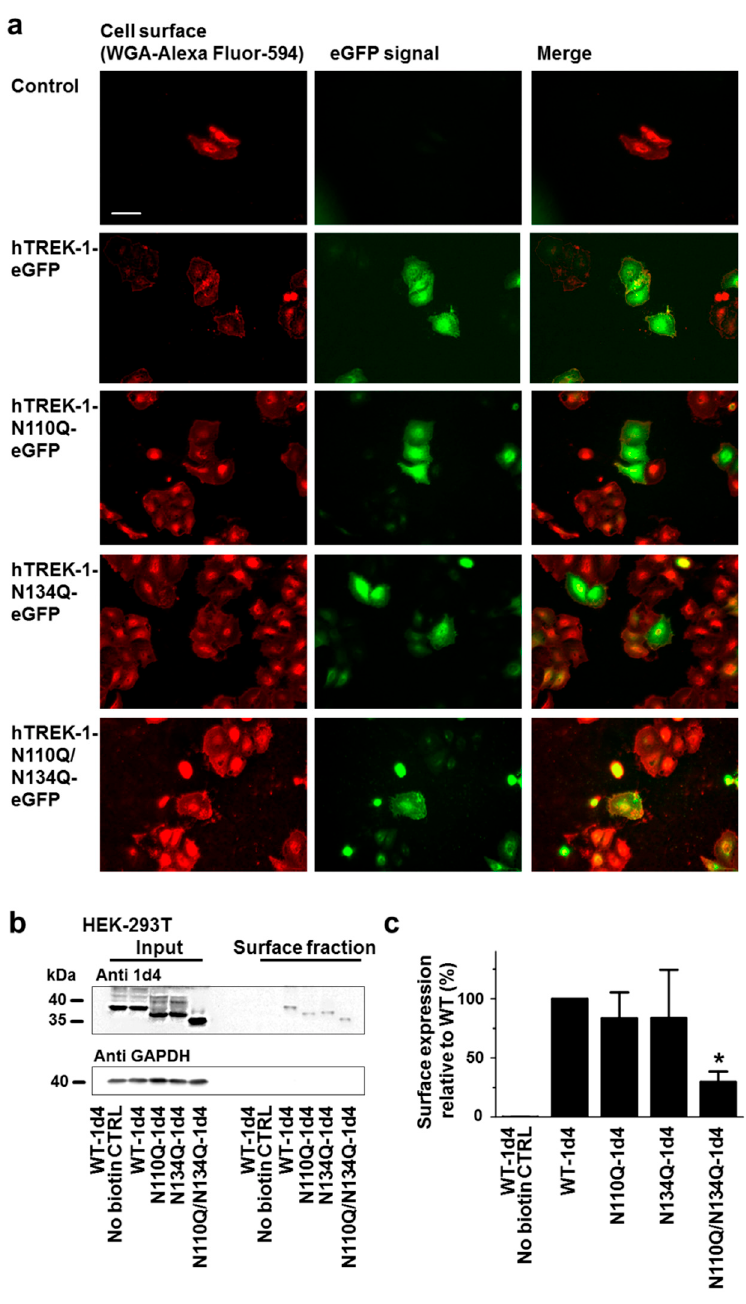
Figure 5. N -glycosylation regulates the surface expression of hTREK-1 channels. ( a ) EGFP-reporter coupled WT hTREK-1 channel subunits or glutamine mutants lacking either one or both N -glycosylation motifs were expressed in HeLa cells. Cell membranes stained with Alexa Fluor 594-labeled wheat germ agglutinin are depicted in red. The fluorescence signals of hTREK-1-eGFP variants are shown in green. The overlays (yellow) demonstrate colocalization of diglycosylated, monoglycosylated and nonglycosylated double-mutant channels with the cellular membrane, and show the preserved surface tra ffi cking of deglycosylated channels. Scale bar: 10 µ m. ( b ) Surface fractions of HEK-293T cells expressing the indicted hTREK-1 N -glycosylation-deficient variants were isolated via surface protein biotinylation, followed by streptavidin precipitation. Immunoblots of the input fractions are displayed on the left, and the mean immunosignals of the surface fractions are given on the right side ( n = 3). ( c ) Ion channel subunit surface fractions (i.e., mean optical densities of the surface blots divided by the input fraction standardized by glyceraldehyde 3-phosphate dehydrogenase (GAPDH) as a loading control relative to the WT signal). The data are provided as the mean ± SEM (* p <